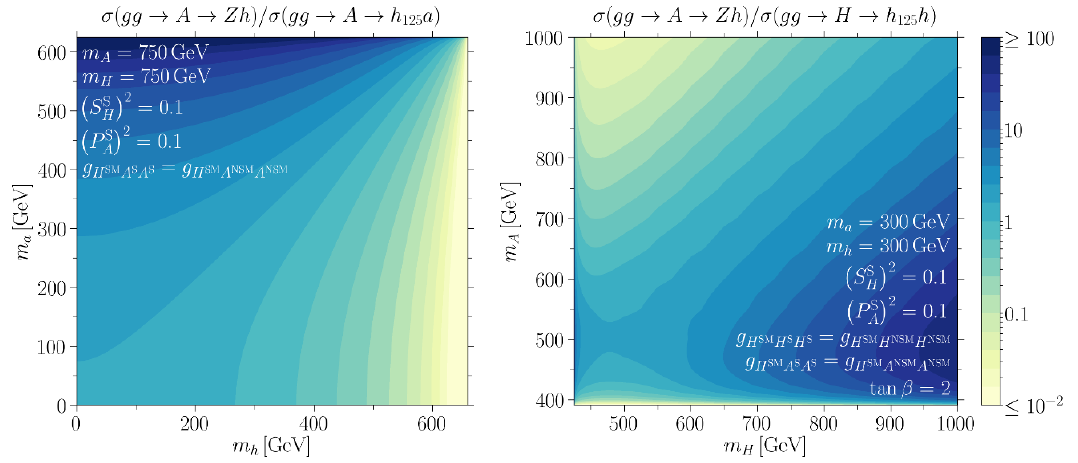
Figure 3 . Same as (cid:12)gure 1 but in the plane of the most relevant masses: ( m h vs. m a ) in the left panel and ( m H vs m A ) in the right